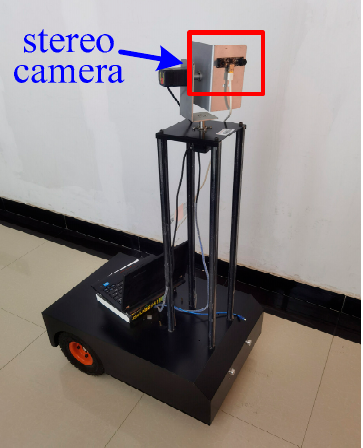
Figure 10. Stereo camera and simulated planetary rover.